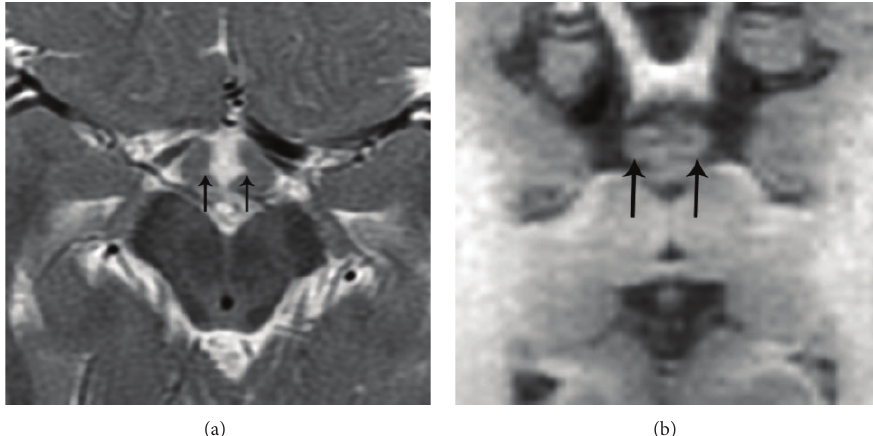
Figure 4: Axial T2WI (repetition time msec/echo time msec, 4400/103) (a) and reformatted oblique axial SPGR T1WI (repetition time msec/echo time msec/inversion time msec, 11/5/500) (b) demonstrating small, broad based diverticula involving the tuber cinereum that contain 3rd ventricular cerebrospinal fluid (arrows).